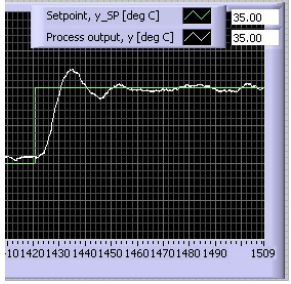
Figure 16: Setpoint Overshoot method: The responses with a P-controller with gain K c 0 = 1 . 8 .